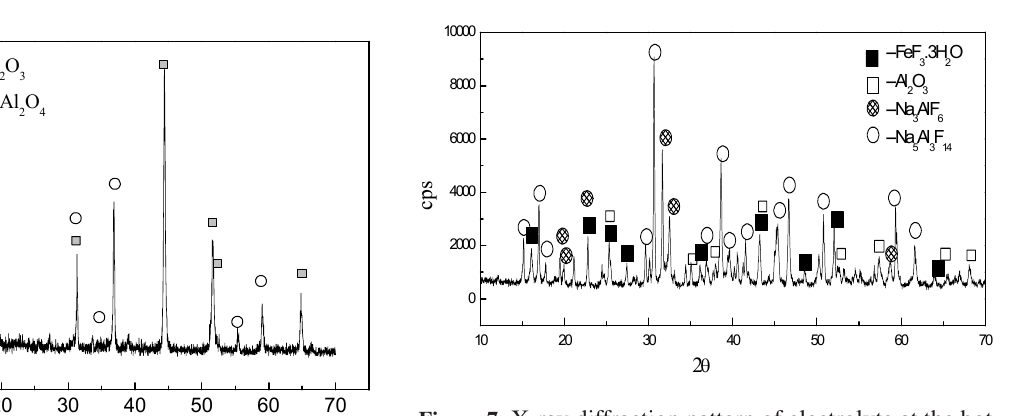
Figure 7. X-ray diffraction pattern of electrolyte at the bot- tom of cell electrolyzed by Fe-Ni-Al 2 O 3